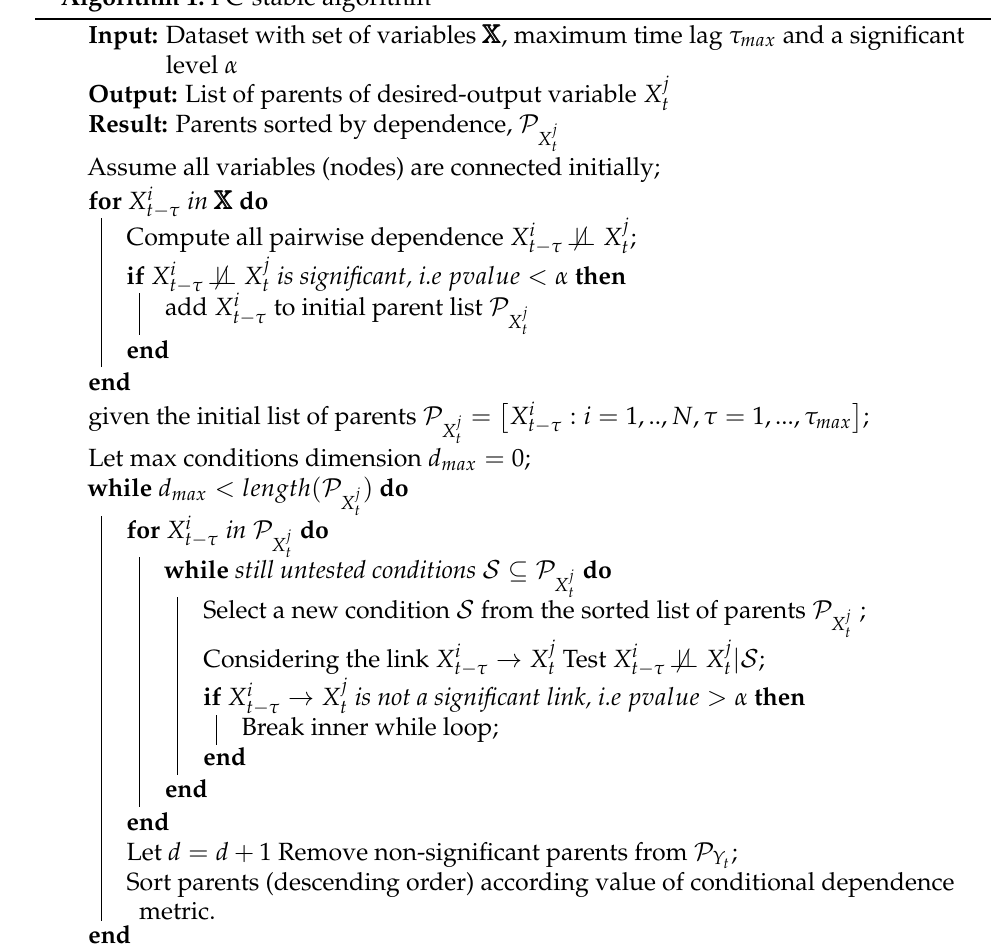
Algorithm 1: PC-stable